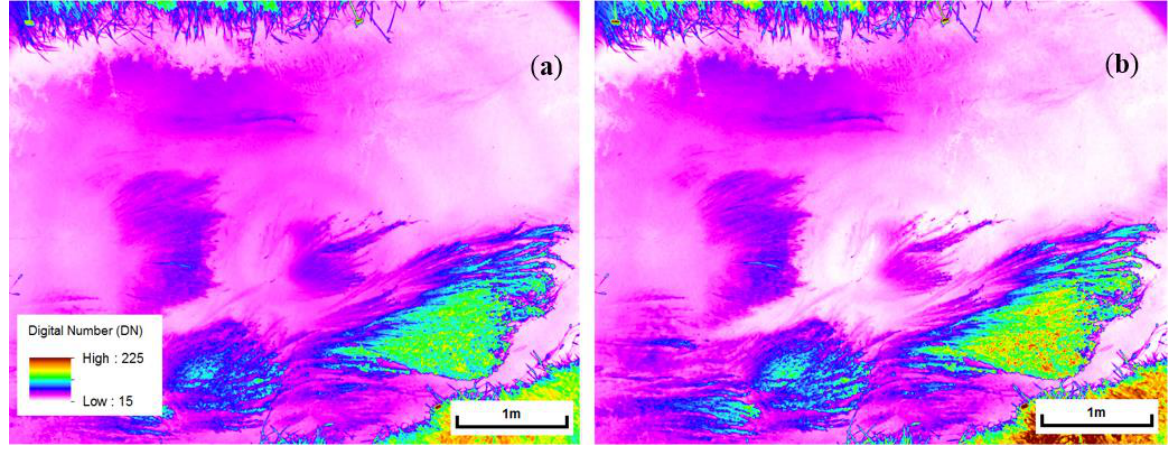
Figure 10. Comparison of NIR(BP2) image for site 1b before ( a ) and after ( b ) radiometric correction of flare effect (‘temperature’ style colour ramp used to enhance DN